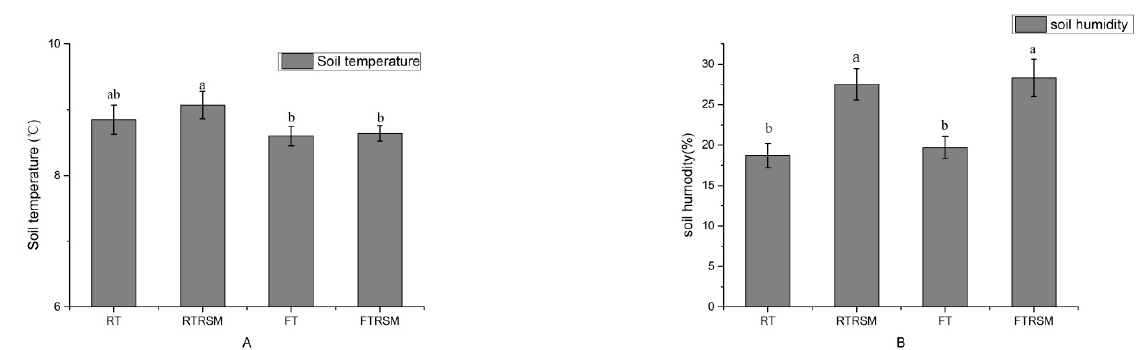
Figure 3. Soil temperature and soil humidity under different treatments. ( A ), soil temperature under different treatments. ( B ), soil humidity under different treatments. FT. flat tillage without any mulch; FTRSM, flat tillage with rice straw mulched; RT. ridge tillage without any mulching; RTRSM, ridge tillage with rice straw mulched. Different lowercase above histogram indicates significant difference between treatments.